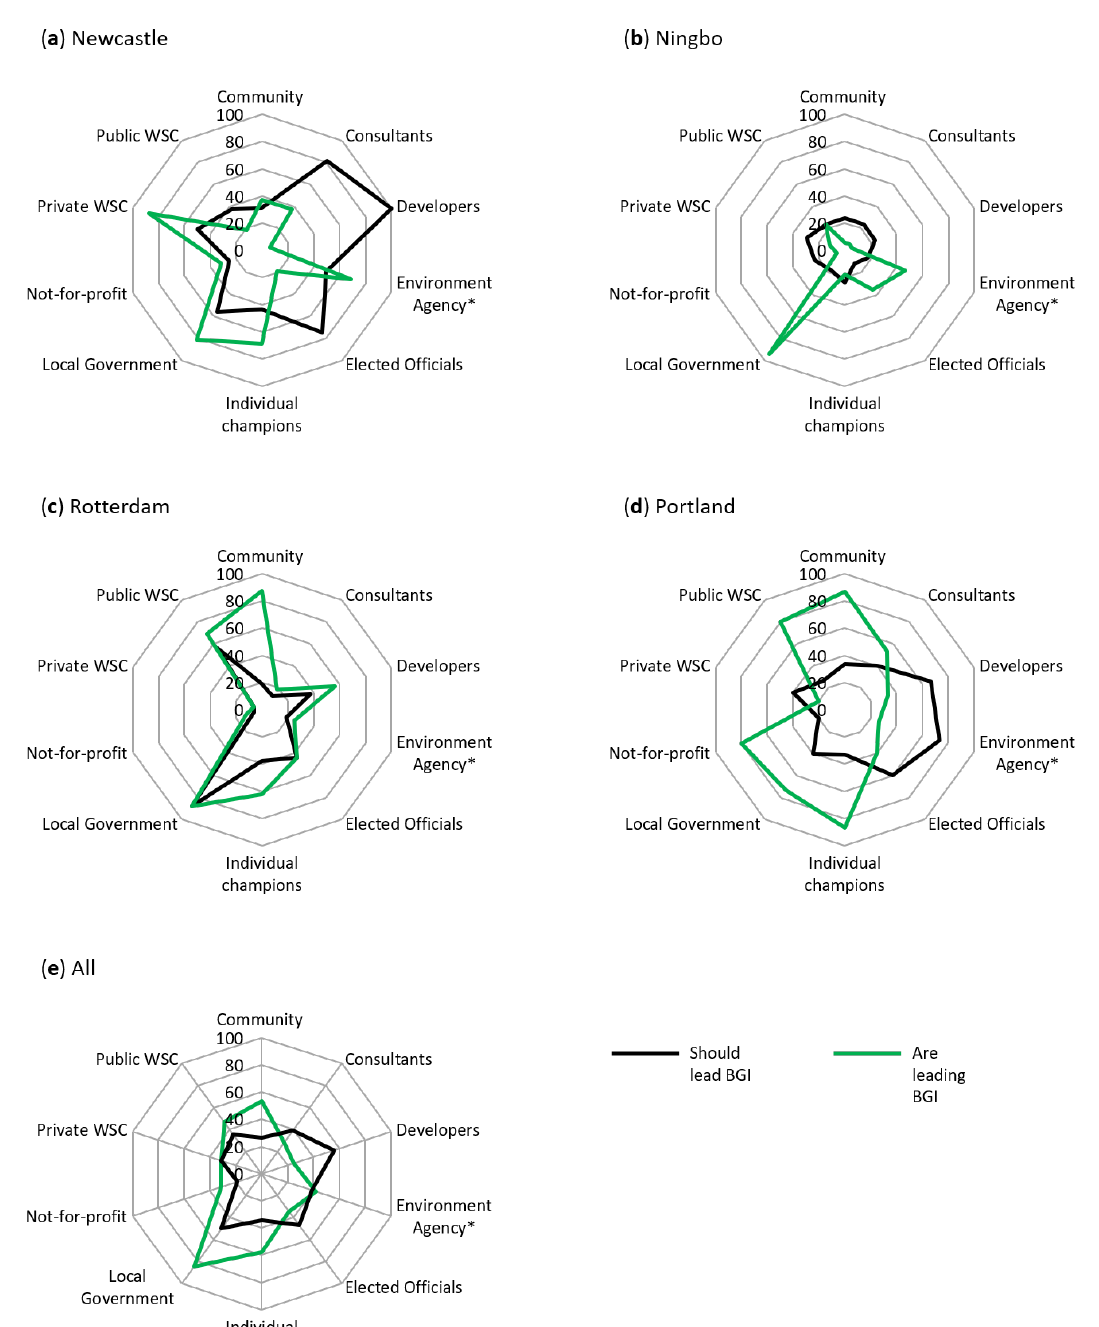
Figure 6. Radar chart showing the perceptions of organisations and individuals that are leading the way, and who should lead the way, in Blue-Green Infrastructure (BGI) implementation in the four case study cities ( a – d ) and all data ( e ). The axes show the percentage of respondents that selected each group and the radii (or spokes) represent the different groups. For example, in Newcastle, 100% of respondents thought that developers should lead the way in BGI implementation as illustrated by the black line to the outer edge of the chart. Respondents were able to select multiple responses for both who should lead and who are leading, explaining why the sum of the radii for each city exceed 100%. WSC (Water and Sewer- age Companies). *Environment Agency refers to the relevant national organisation in each country, e.g., the Environment Agency (UK), Environmental Protection Agency (USA), Ministry of Infrastructure and Water Management (Netherlands) or the Housing and Construction Bureau (China).